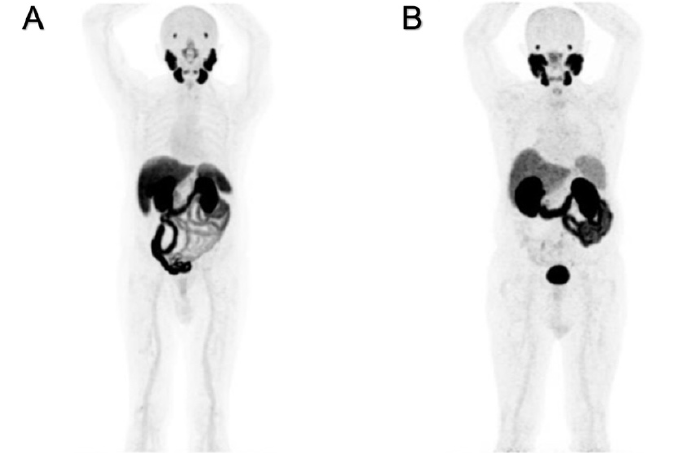
Figure 2. Negative PET/CT scans: patient ( A ) was examined with [ 18 F]PSMA ‐ 1007, and patient ( B ) was examined with [ 68 Ga]Ga ‐ PSMA ‐ 11.